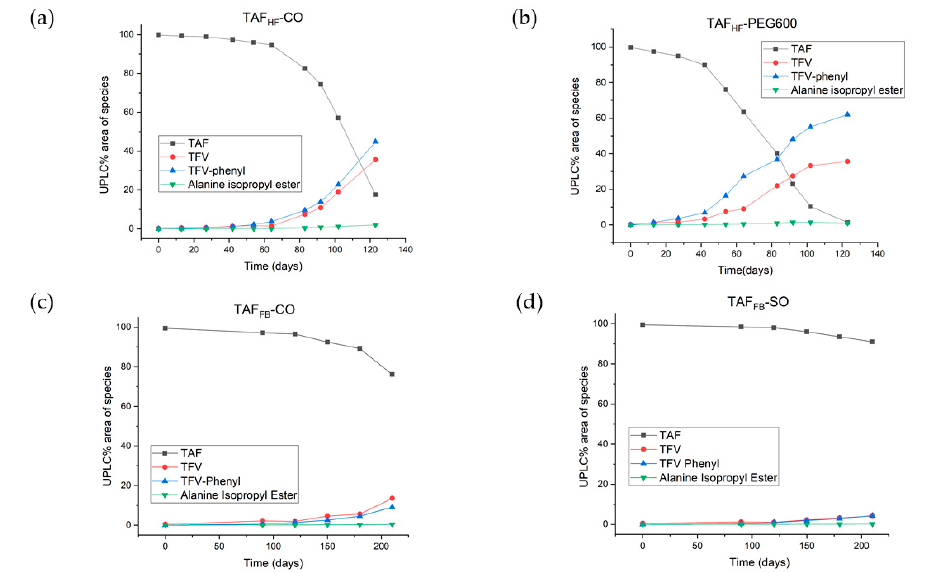
Figure 6. Chromatographic impurity profile of TAF HF -CO ( a ), TAF HF -PEG600 ( b ), TAF FB -CO ( c ), and TAF FB -SO ( d ) formulations.